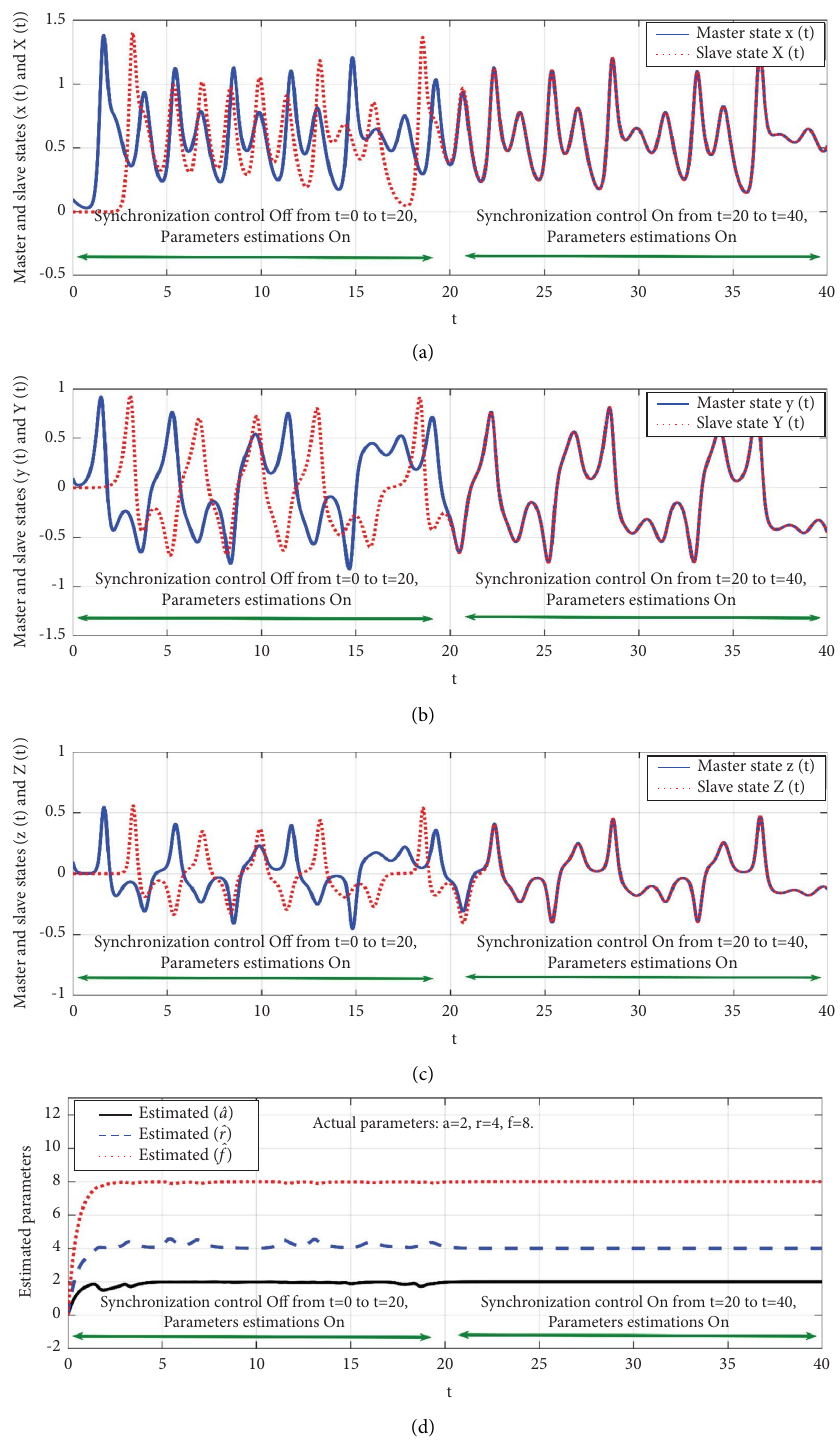
Figure 13: Te evolution of the chaotic system time response before and after chaos synchronization when the system parameters � β � 2 . 0 , ( i � 1 , 2 , 3 ) , and initial conditions x ( 0 ) � y ( 0 ) � z ( 0 ) � 0 . 1 , a � 2 ,b � 7 , r � 4 ,g � 11 ,f � 8 , c � 5, control gains α i i X ( 0 ) � Y ( 0 ) � Z ( 0 ) � 0 . 0001 , 􏽢 a ( 0 ) � 􏽢 r ( 0 ) � 􏽢 f ( 0 ) � 0 . 0. (a–c) the evolution of both the master and slave systems states x ( t ) ,y ( t ) , z ( t ) ,X ( t ) , Y ( t ) , and Z ( t ) before chaos synchronization on the interval 0 ≤ t < 20 and after chaos synchronization on the interval 20 ≤ t ≤ 40 and (d) the evolution of the system estimated parameters 􏽢 a, 􏽢 r, and 􏽢 f